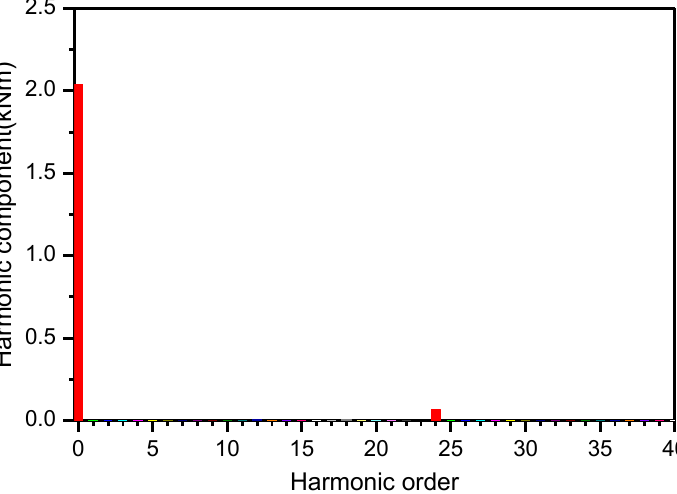
Figure 27. Torque waveforms of two units of motor and their total torque.